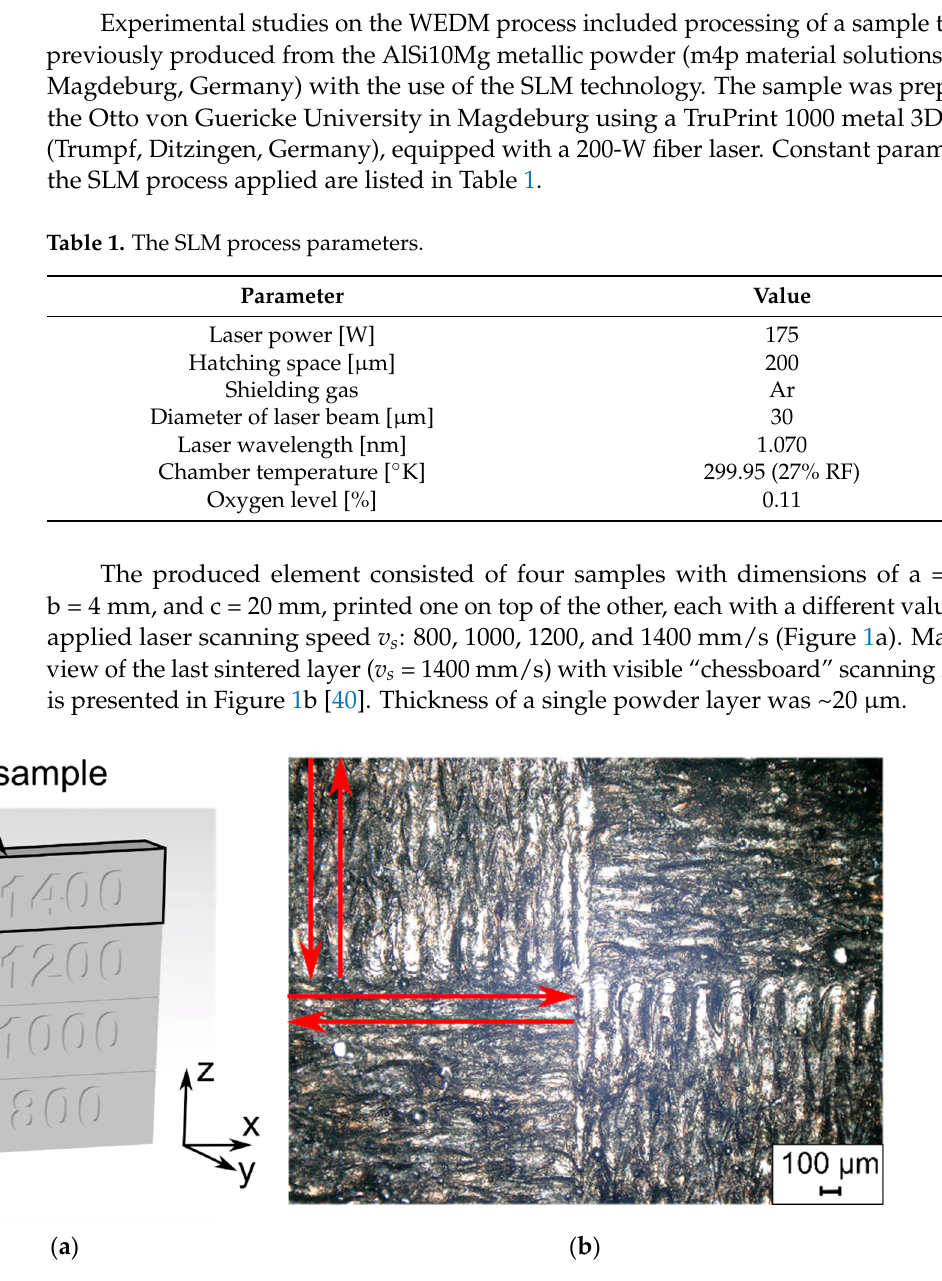
Figure 1. ( a ) The 3D model of specimen; ( b ) a photograph of the applied scanning strategy.